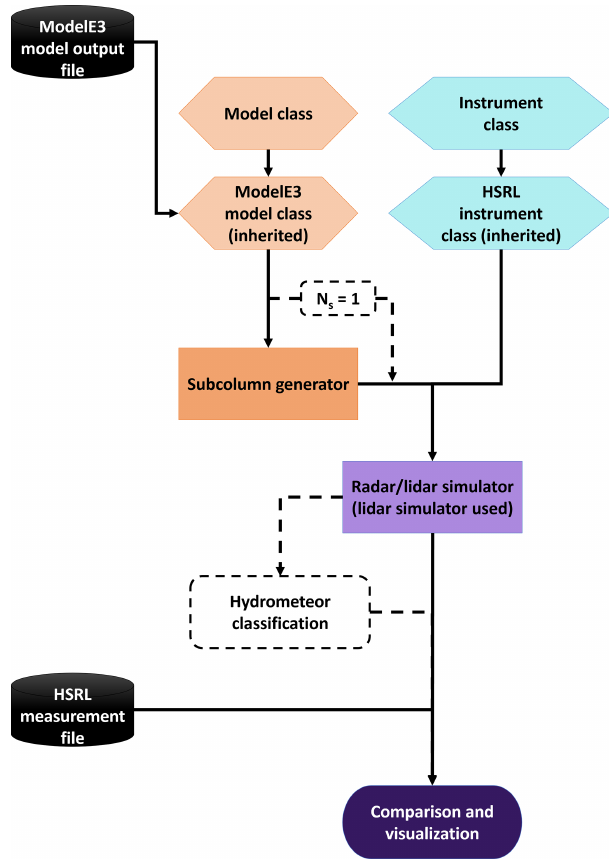
Figure 1. Standard workflow of EMC 2 utilization for direct com- parison between observations and model output. The flowchart ex- emplifies the use of EMC 2 to compare the NASA GISS ModelE3 climate model output with corresponding high spectral resolution lidar (HSRL) measurements. N s designates the specified number of